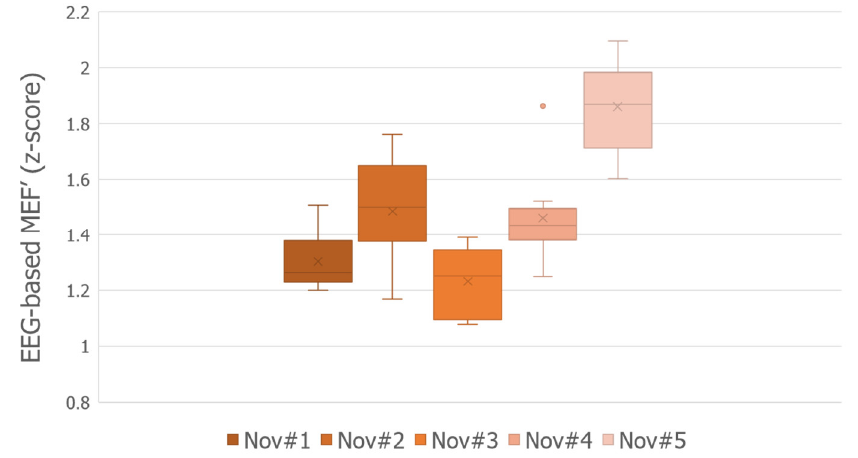
Figure 8. Median MEF’ distributions of the Novices. The MEF’ allowed for quantifying how much each Novice differed from the Expert population regarding mental effort requested during the flight simulation. The colored dots represent outliers within the corresponding data distribution.